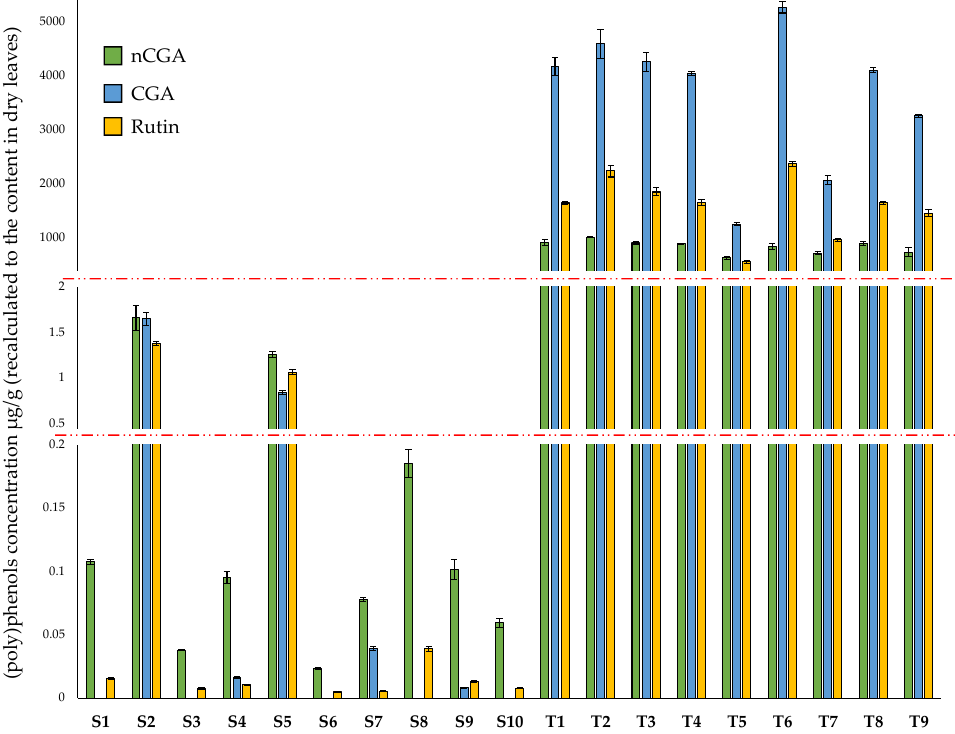
Figure 4. Chlorogenic acid (CGA), neochlorogenic acid (nCGA), and rutin content in samples expressed in µg/g (recalculated to the content in dry leaves). The red dotted lines indicate the gaps on the scale, for (poly)phenols concentration between 0.2-0.5 µg/g and between 2-400 µg/g).